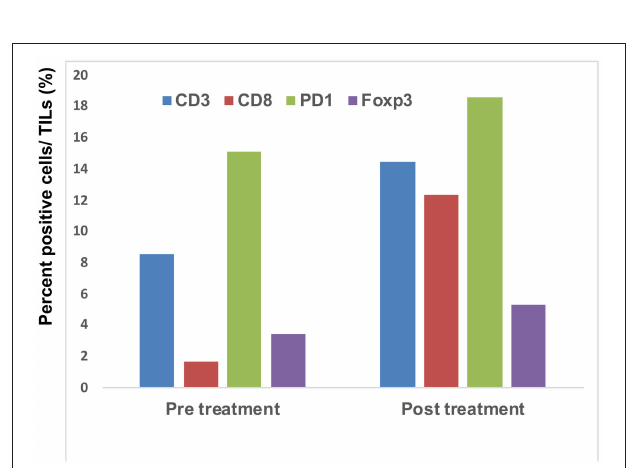
FIGURE 3 | Quantitative analysis of CD3 + T cells, CD8 + T cells, PD1-expressing cells, and Foxp3 + cells: the IHC-positive cells within the lymphocyte fraction and the percentage of IHC-positive cells per all tumor-infiltrating cells were automatically counted using a